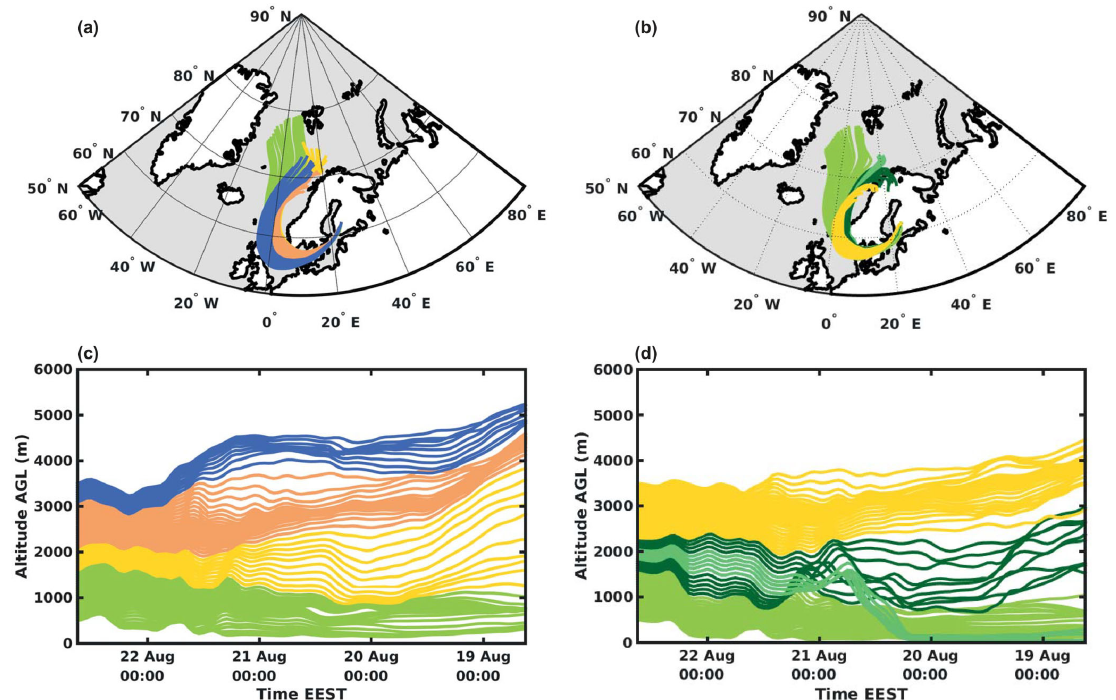
Figure 8. Same as Fig. 3 except for Case II with (a) and (c) showing trajectories arriving at 10:00 and panels (b) and (d) at 14:00.